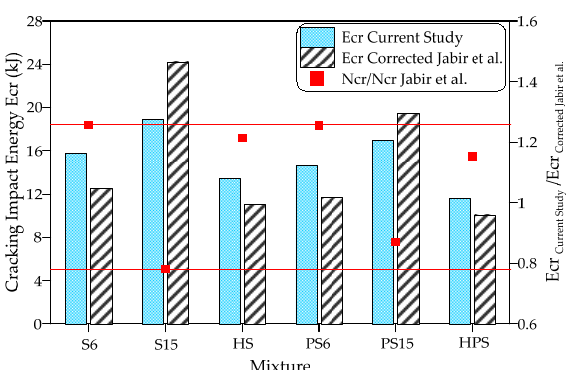
Figure 15. Comparison of corrected cracking impact energy Ecr values of Jabir et al. [67] with those of the current study.